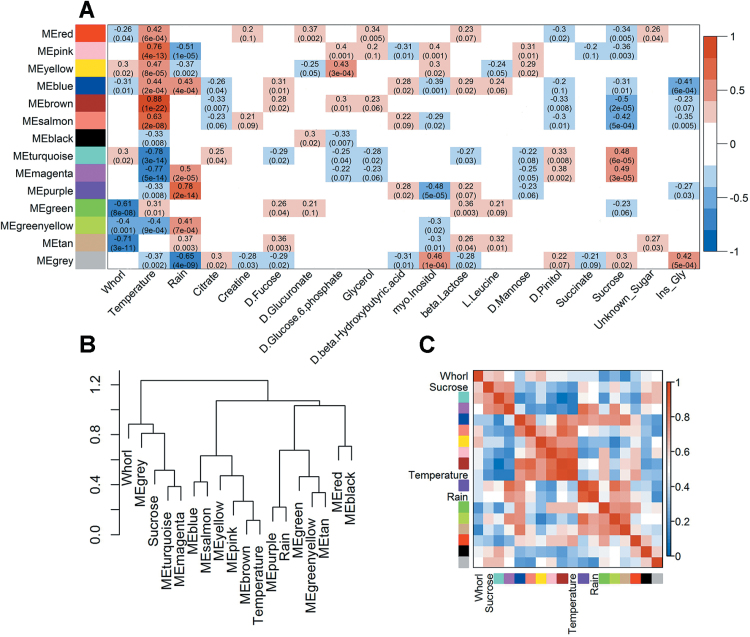
Correlations between eigengene modules, traits, and inter-module relationships. (A) Pearson correlations between the eigengene modules and metabolites, and Whorl, Temperature, and Rain, with P-values in parentheses. Only traits with at least one significant correlation (P < 0.05) with a module are presented. (B) Eigengene dendrogram. (C) Adjacency heatmap. Colours in the name positions refer to the modules’ names. Colours in the matrix boxes show the magnitude and direction of the correlations: intense blue and red indicate strong negative and positive correlations, respectively. High temperature is positively correlated with high gene expression. Older whorls are positively correlated with high levels of gene expression.